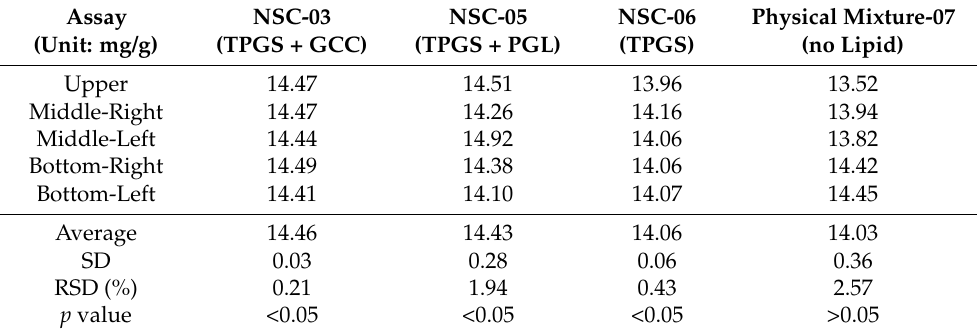
Table 4. Dutasteride content homogeneity in NSCs.